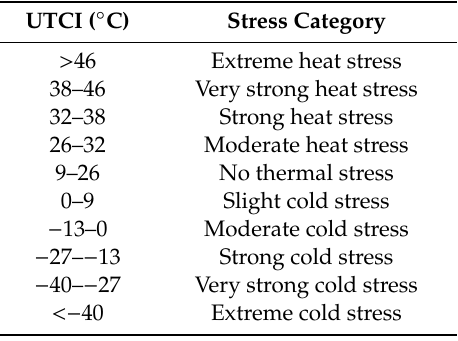
Table 2. Thermal stress categories according to Universal Thermal Climate Index (UTCI)